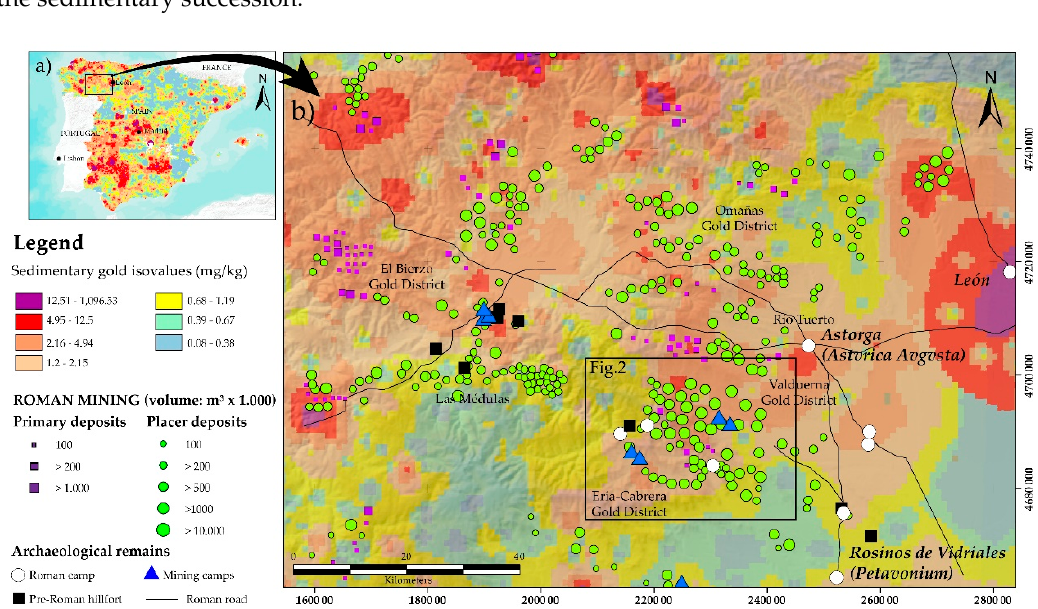
Figure 1. ( a ) Distribution of auriferous sedimentary deposits in Spain. ( b ) 1 km cell interpolation of sedimentary gold isovalues (mg/kg) in the studied region and its surroundings in northwest Spain and distribution of Roman gold mining works and related infrastructure. Data from the Spanish Geological Survey [46].